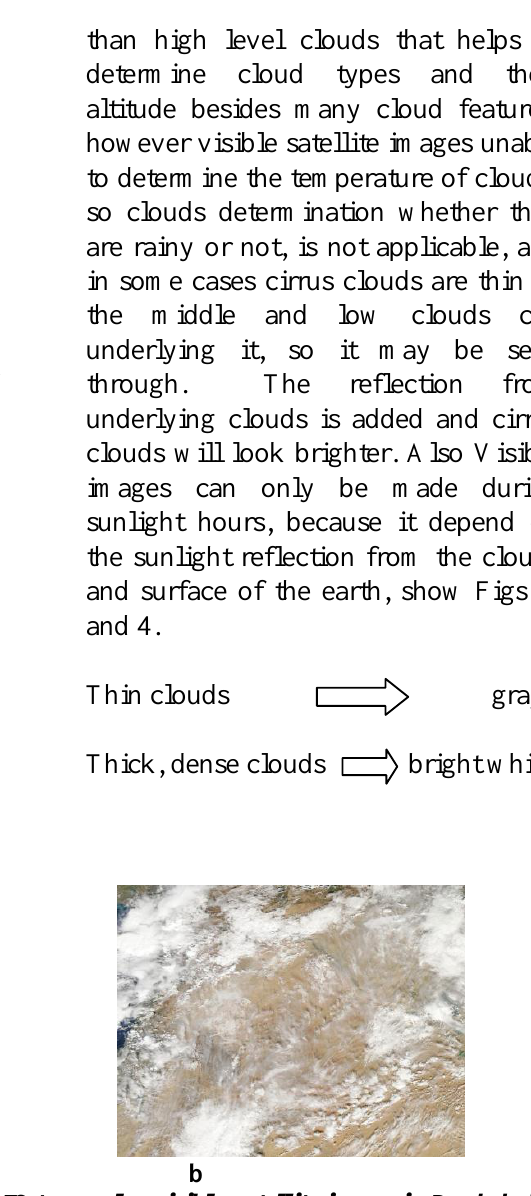
Fig.3: a) GEOS satellite image. b) MODIS true color visible satellite image in